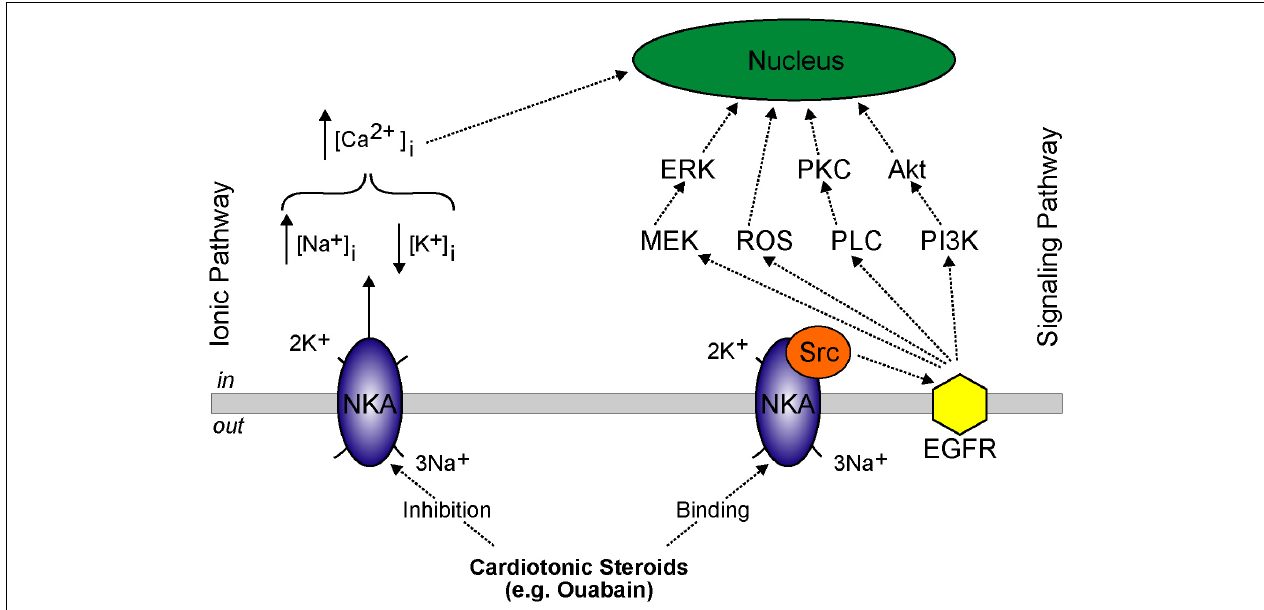
FIGURE 3 | Model showing basolateral NKA ionic and signaling pathways. Ionic pathway involves: (i) high dose cardiotonic steroids inhibiting NKA activity, (ii) increased intracellular Na + concentration, (iii) decreased intracellular K + concentration, and (iv) increased intracellular Ca 2 + concentration inducing genomic effects in the nucleus. Signaling pathway involves: (i) low dose cardiotonic steroid binding, (ii) release of Src, (iii) activation of EGFR, and (iv) signaling cascade activation of mitogen-activated protein kinase kinase (MEK/ERK), ROS generation, PLC/PKC activation, and PI3K/Akt